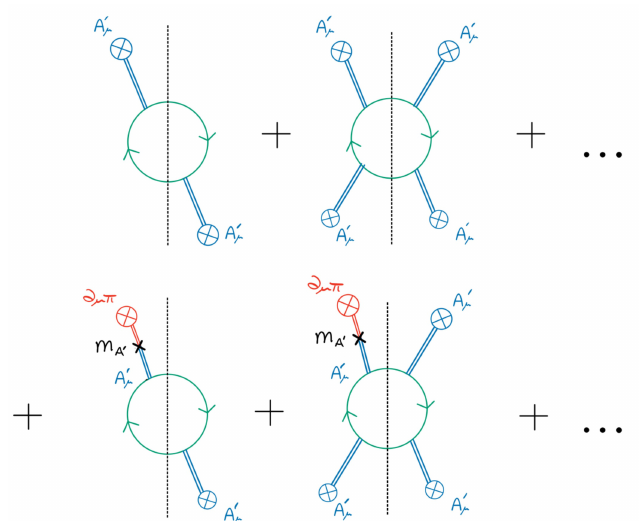
Figure 13. Diagrammatic expansion of the one-loop effective action L eff of a theory of QED with a massive photon. The rate of vacuum decay is related to the imaginary part of L eff via the optical theorem (represented as usual by a vertical cut in the diagrams). The main difference from a theory with a massless photon is the scalar degree of freedom π which must in principle be taken into account as an external field and can oscillate into A 0 via a mass vertex m A 0 . However, because µ of the Ward identity (i.e. because the current J µ = ψγ µ ψ is conserved), such diagrams evaluate to